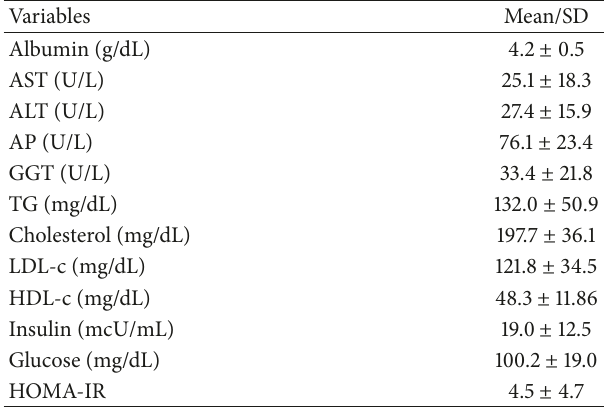
Table 2: Biochemical variables of the sample ( 𝑛 = 50